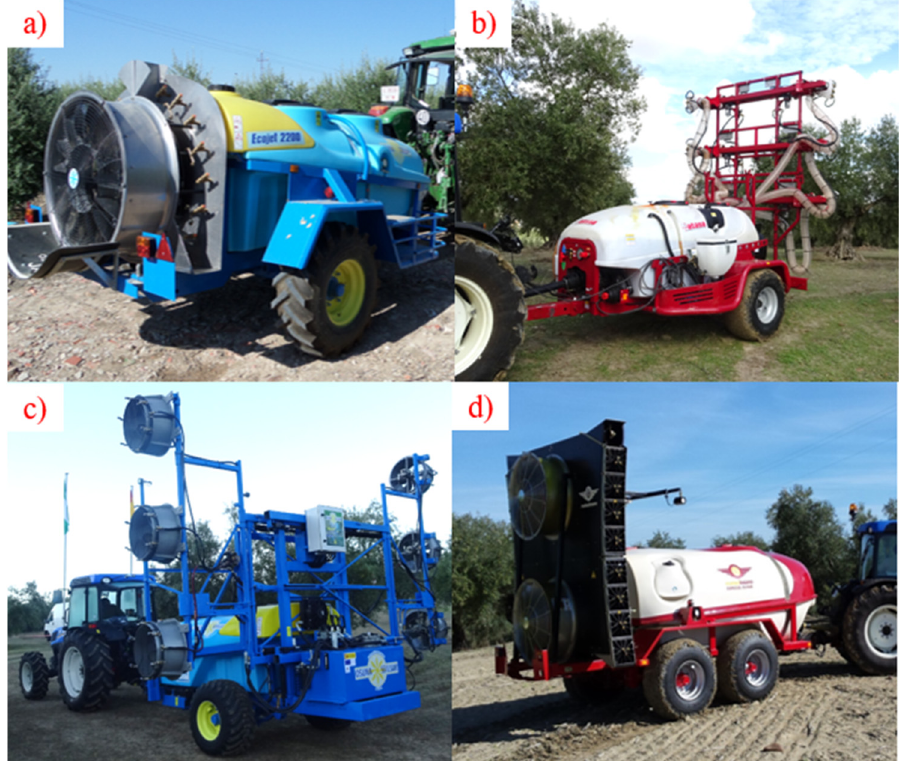
Figure 3. Sprayers used in the trial: ( a ) Conventional air blast sprayer; ( b ) P1 prototype; ( c ) P2 prototype and ( d ) P3 prototype.